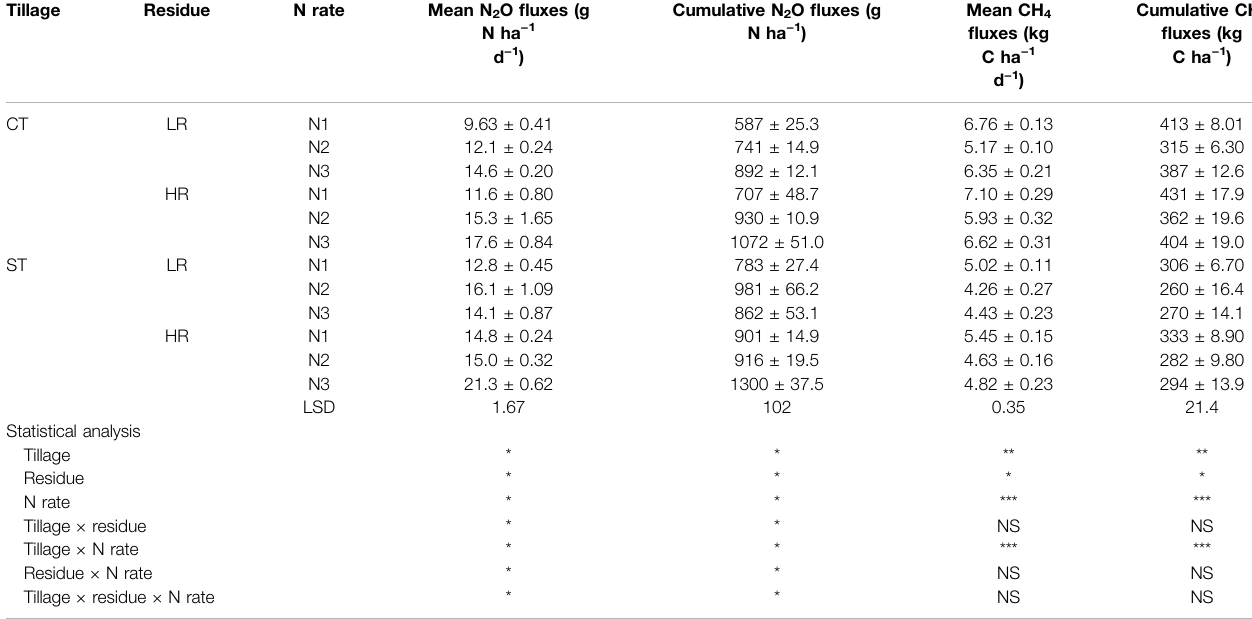
TABLE1| Effectoftillagesystems(conventionaltillage,CT,andstriptillage,ST),residuelevels(lowresidue,LR,andhighresidueHR),andNapplicationrates(108,144,and 180 kg ha − 1 ) on mean and cumulative N 2 O and CH 4 emissions in rice paddy (Boro rice) ( n = 3; mean ± SE).